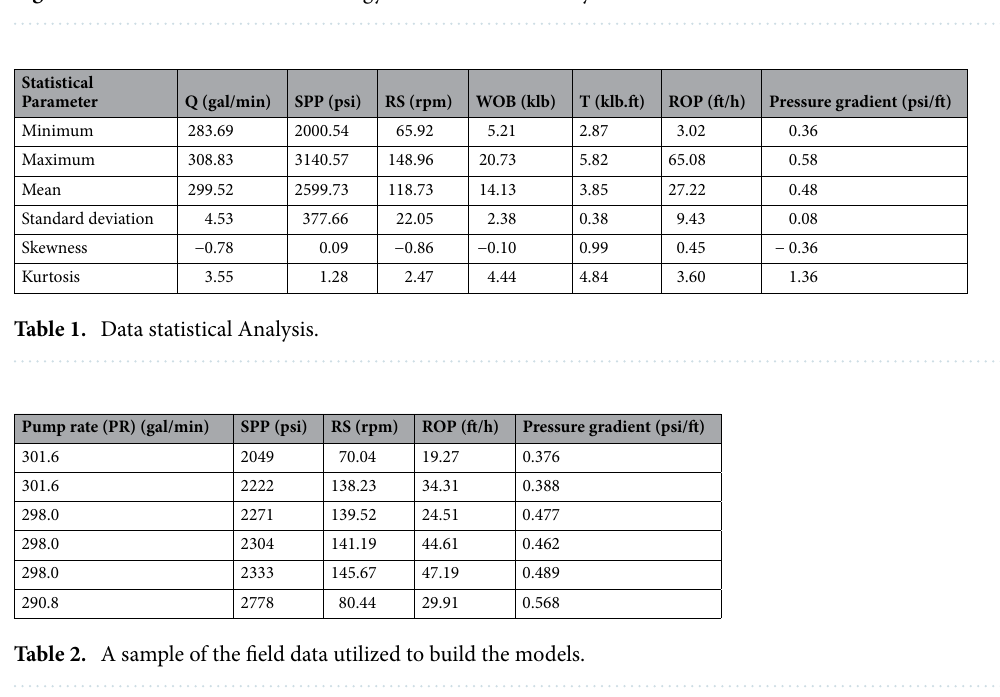
Figure 1. Flow chart of the methodology conducted in the study.